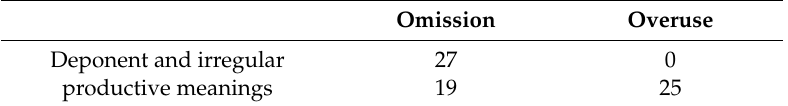
Table 4. Di ff erent meanings of - s j a : omission vs. overuse (Tungusic and Samoyedic) 8 .